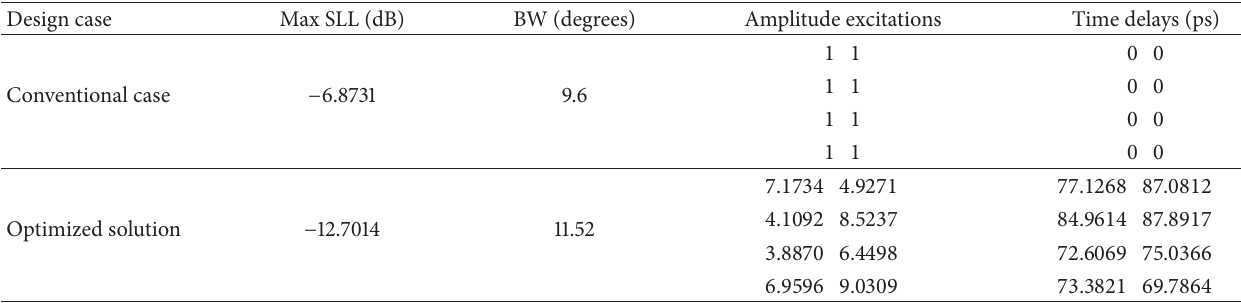
Table 1: Comparison of numerical values between the conventional case and the optimized solution by DEMO/parent for the steerable energy pattern shown in Figure 4 (amplitude and time delays values are for the case 𝜙 0 = 0 ∘